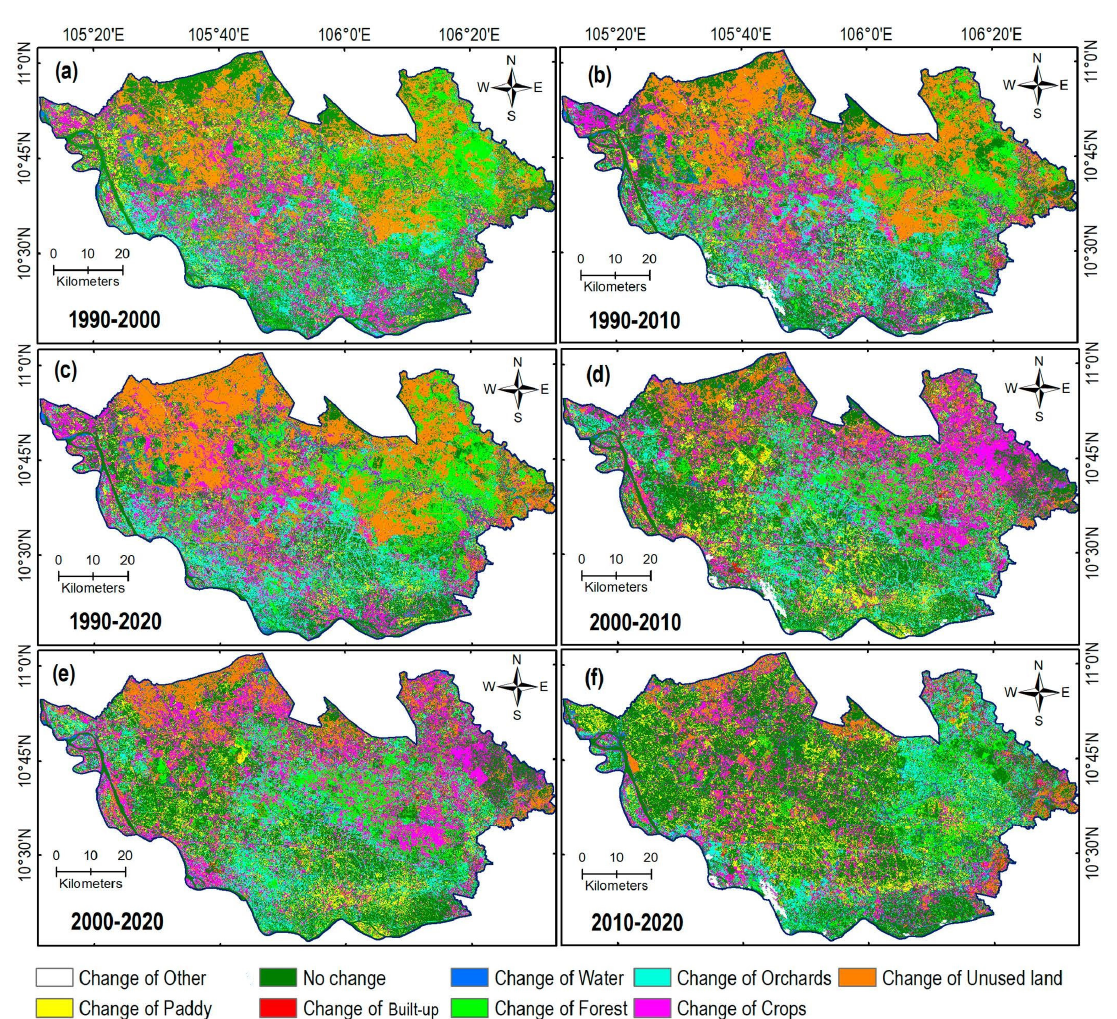
Figure 9. Distribution of LULC changes in the Dong Thap Muoi area for the different periods: ( a ) 1990–2000; ( b ) 1990–2010; ( c ) 1990–2020; ( d ) 2000–2010; ( e ) 2000–2020; ( f )